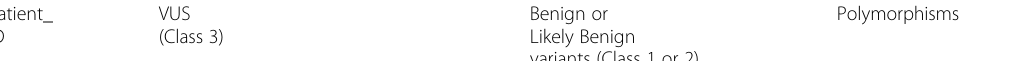
Table 2 Characterization of germline variants found among Norwegian familial CRC individuals